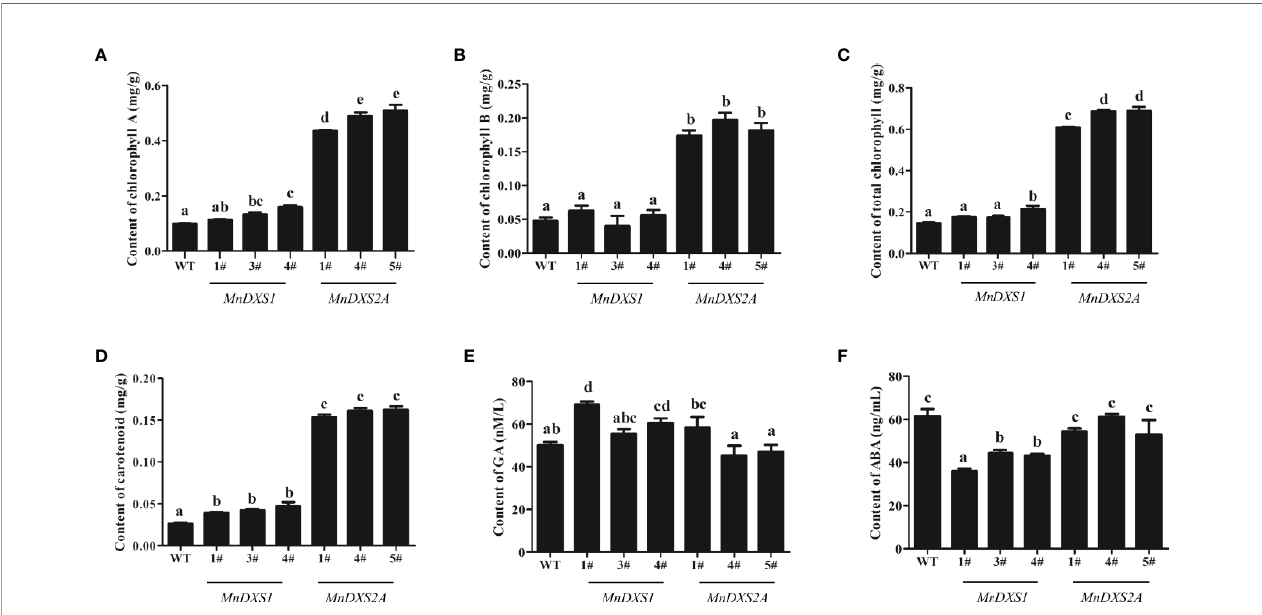
FIGURE 6 | Chlorophyll (A – C) , carotenoid (D) , GA (E) , and ABA (F) content in WT plants and MnDXS1 - MnDXS2A -overexpressing transgenic lines. Data are presented as the mean ± standard error of the mean of three replicates. Different letters above bars represent signi fi cant differences (p < 0.05) as determined with the one-way Duncan ’ s test.